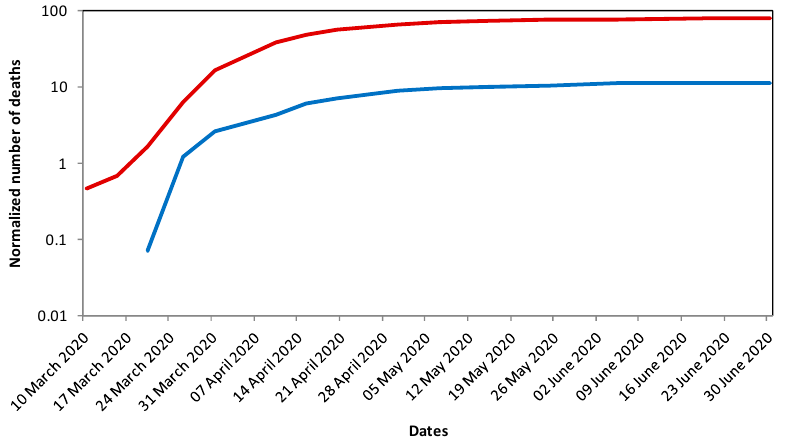
Figure 2. Number of deaths for COVID-19 per 100,000 residents by department in Paris (red line) and Loire-Atlantique (blue line). See https://www.gouvernement.fr/info-coronavirus/carte-et-donnees (accessed on 19 February 2021) .